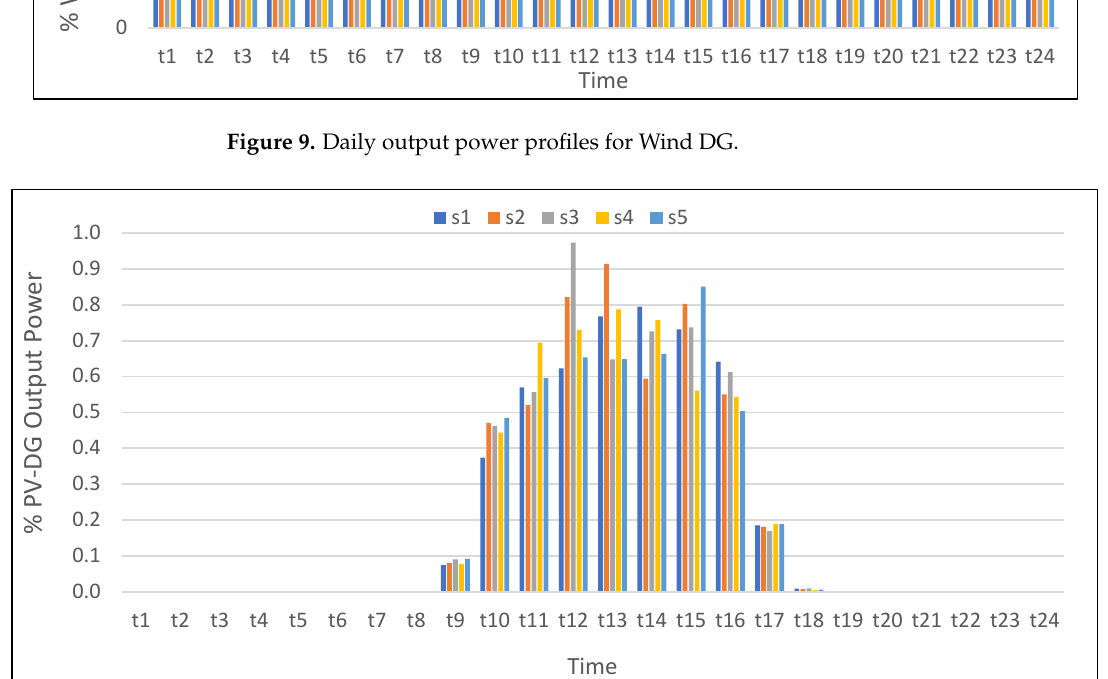
Figure 10. Daily output power profiles for PV ‐ DGs.